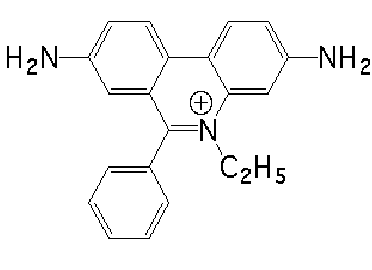
Figure 1. Structure of